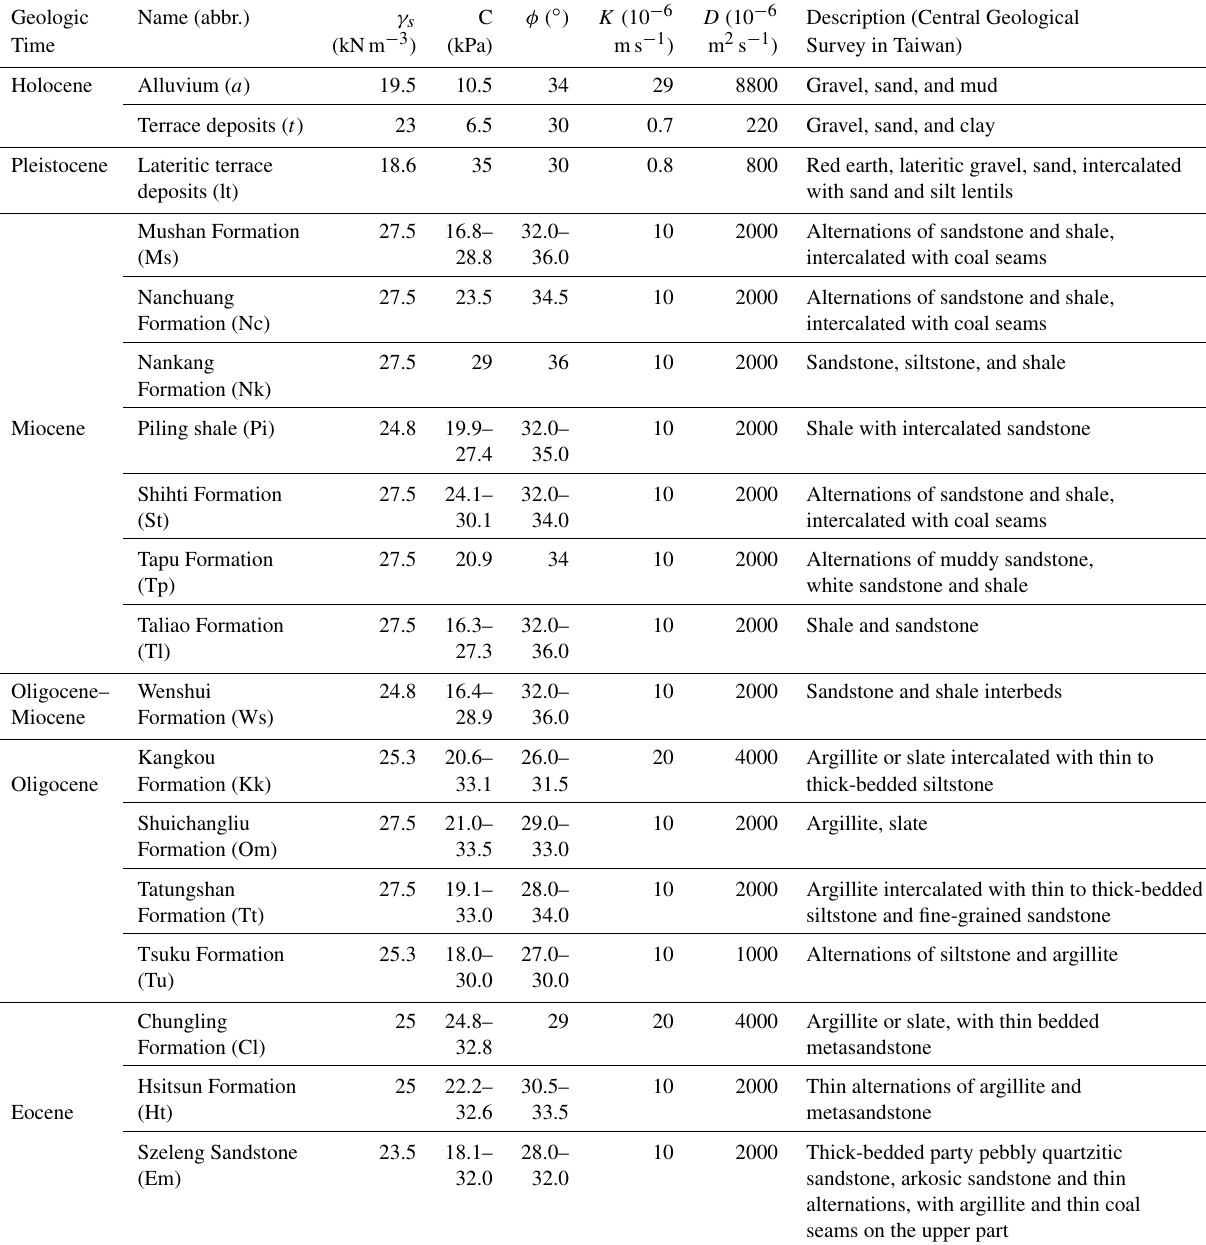
Table 3. The geology description and corresponding parameters used in TRIGRS. Geologic